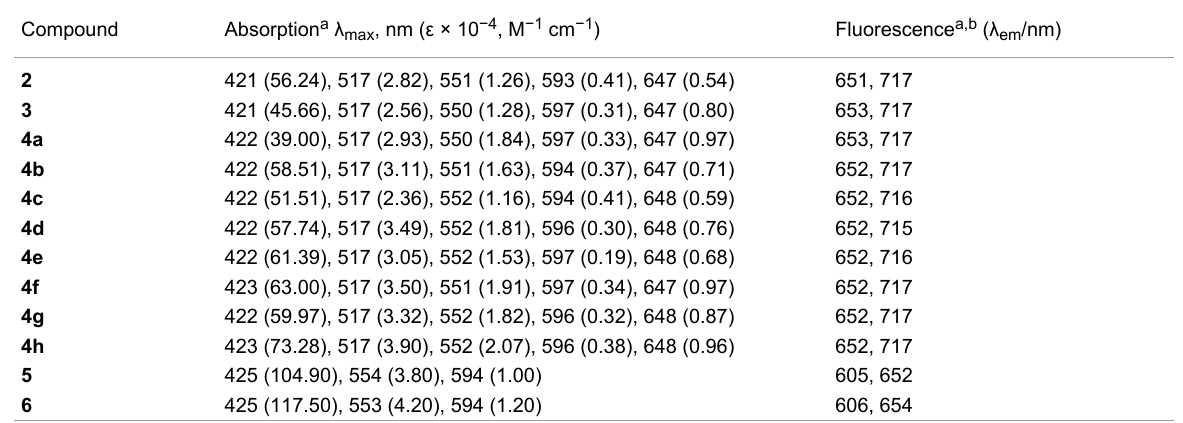
Table 1: Electronic absorption and emission data of porphyrins ( 2, 3, 4a – h , 5 and 6 ). Compound